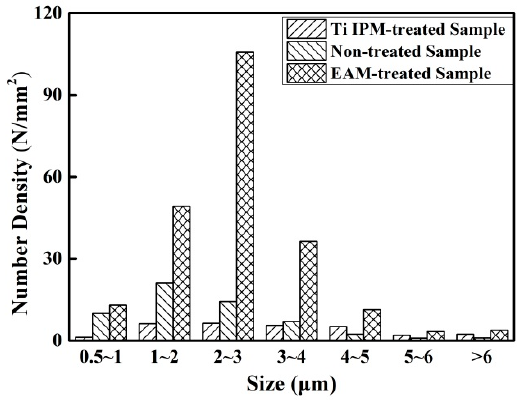
Figure 3. The relationship between oxide size and number density in an EAM-treated sample, a non-treated sample, and a Ti internal precipitation method (IPM)-treated steel sample.